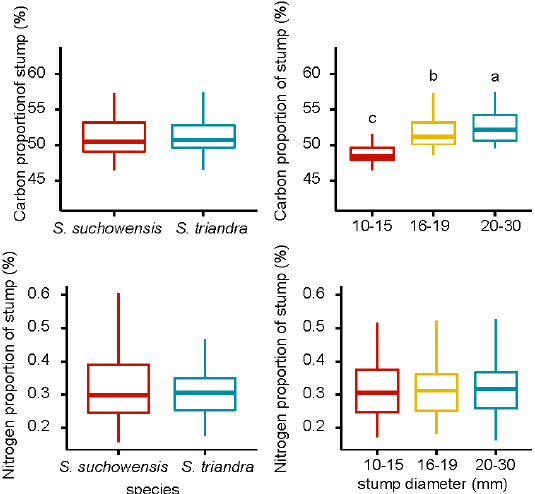
Figure 4. Carbon and nitrogen proportion of willow stumps. Notes: Different letters above bars indicate statistical differences among stump diameter classes according to Tukey’s HSD mean comparison.